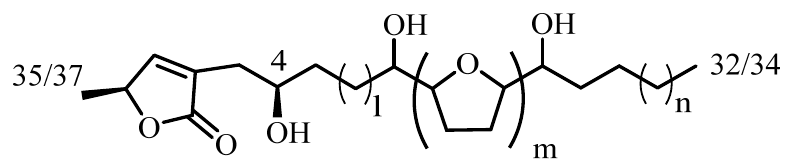
Figure 1. Overview of annonaceous ACG structure.